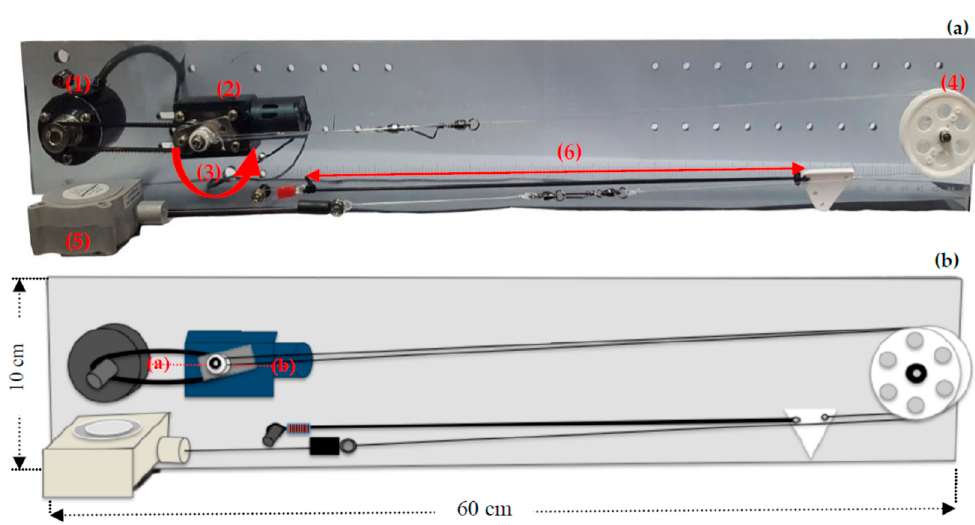
Figure 1. Panel a : picture of the expansion/contraction simulator machine. (1) is the rotary encoder; (2) is the motor; (3) shows the direction of rotation of motor’s arm; (4) refers to the pulley system; (5) is the string potentiometer; (6) is an electro-resistive band; Panel b : Diagram of the expansion/contraction simulator machine. Maximum stretch of the ERB and the SP sensors occurs when the metal arm of the DC motor reaches position ( a ); minimum stretch occurs at position ( b ).